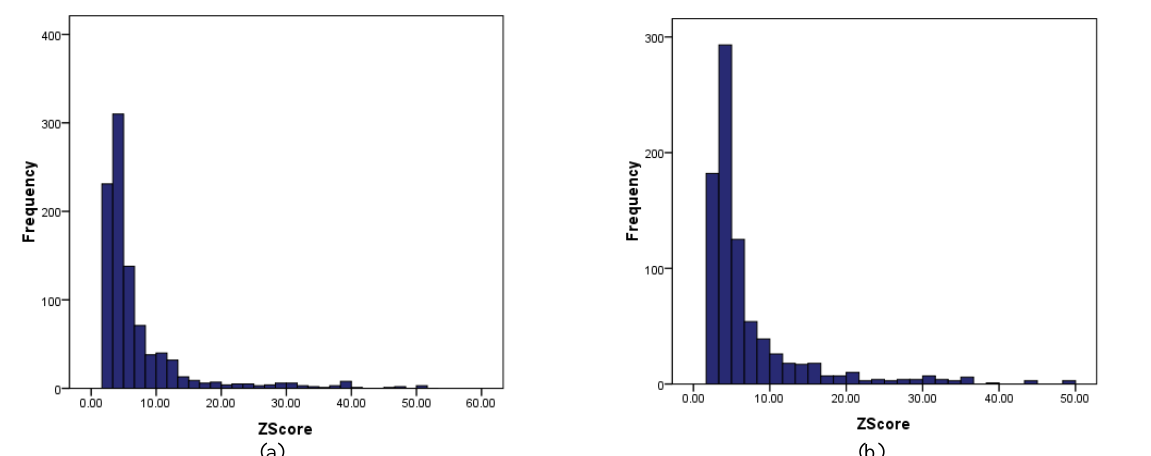
Figure 10. Comparison of Z-Score parameter frequency chart for dangerous Lixels of the accident-prone segments (Z-Score>2.58) with the two kernel functions (a) continuous kernel function (b) discontinuous kernel